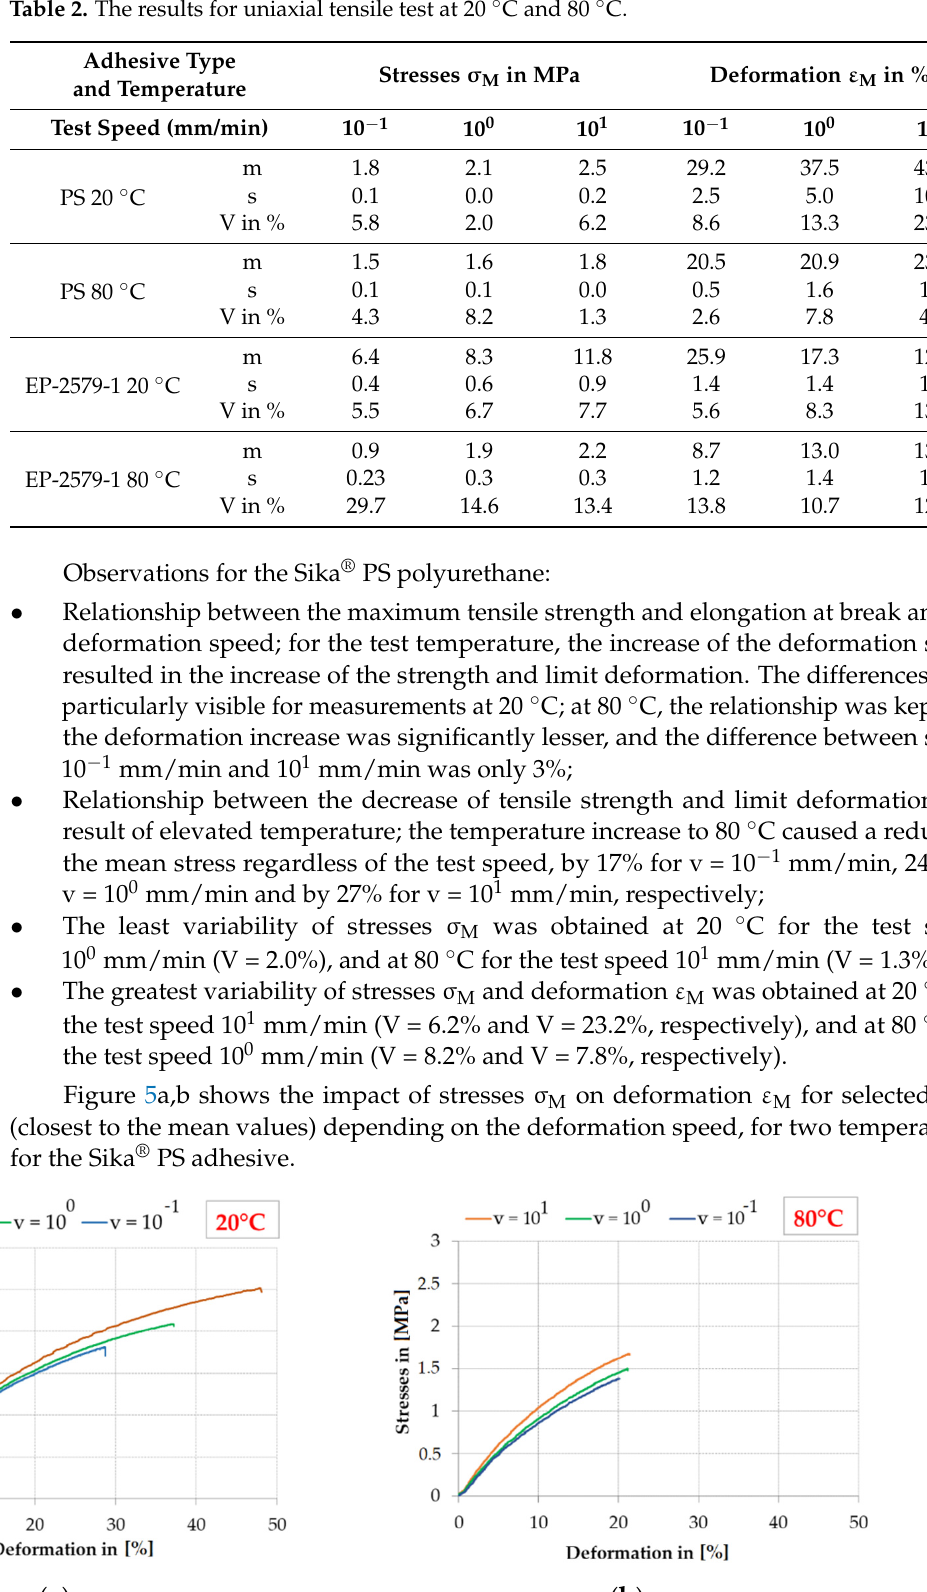
Table 2. The results for uniaxial tensile test at 20 °C and 80 °C.